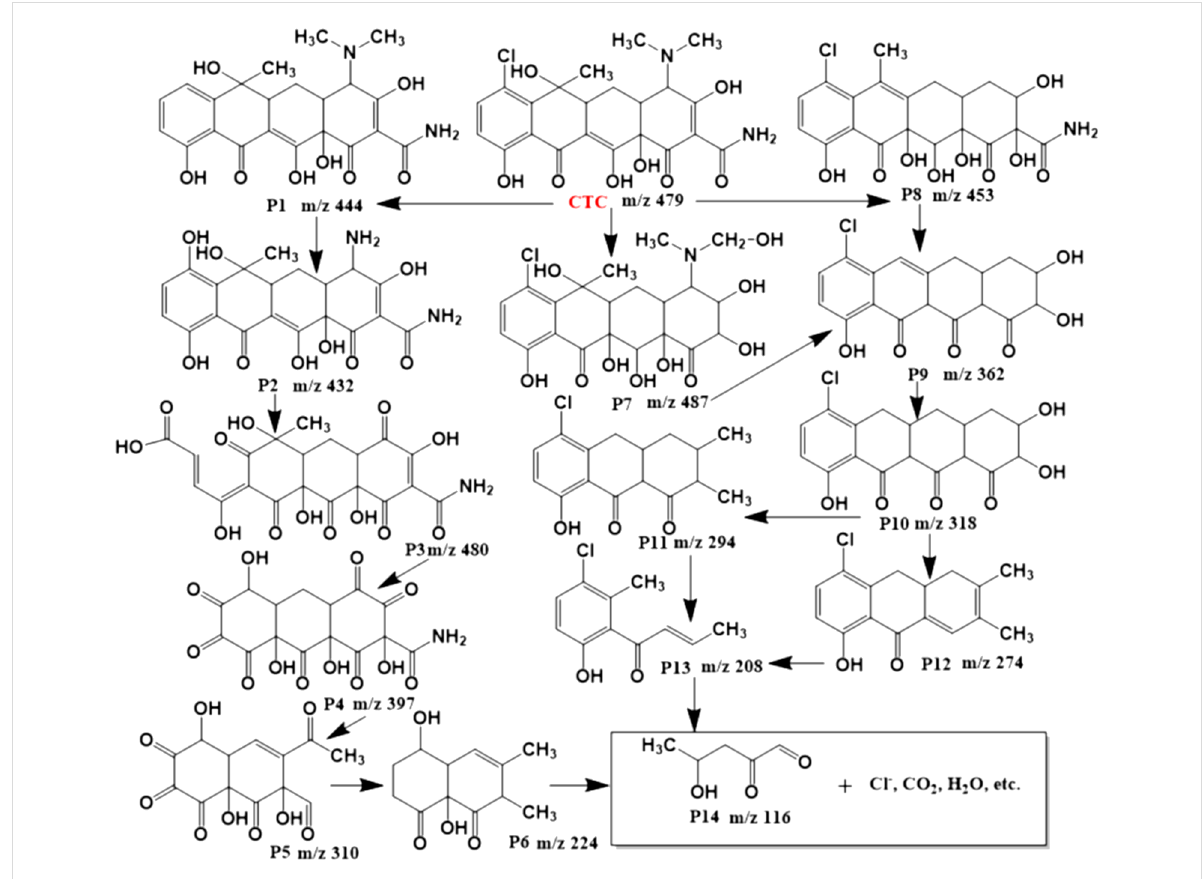
Figure 7: Possible degradation pathways of CTC catalyzed by BOM-20.